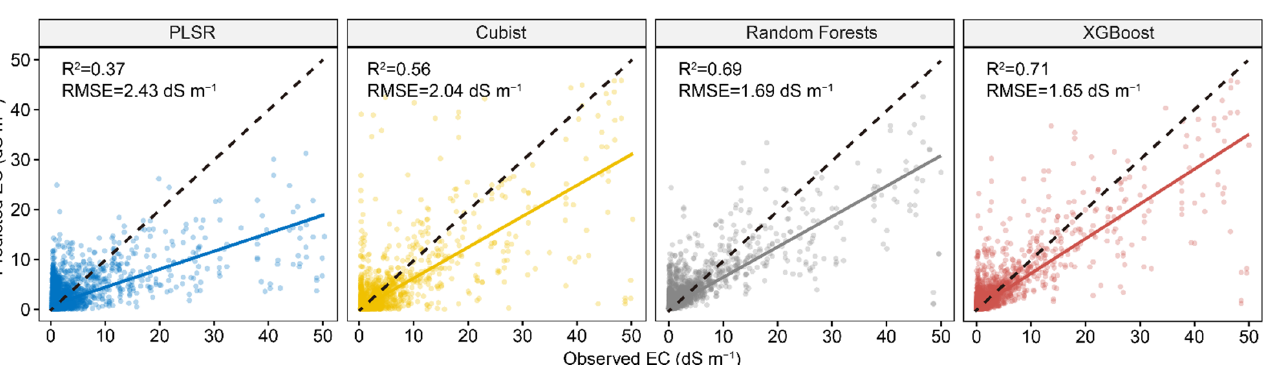
Figure 4. Scatter plots of four spectral predictive models using first 30 PCs of Vis-NIR spectra. The solid line is a fitted line for each model, whereas the dashed line is the 1:1 line.